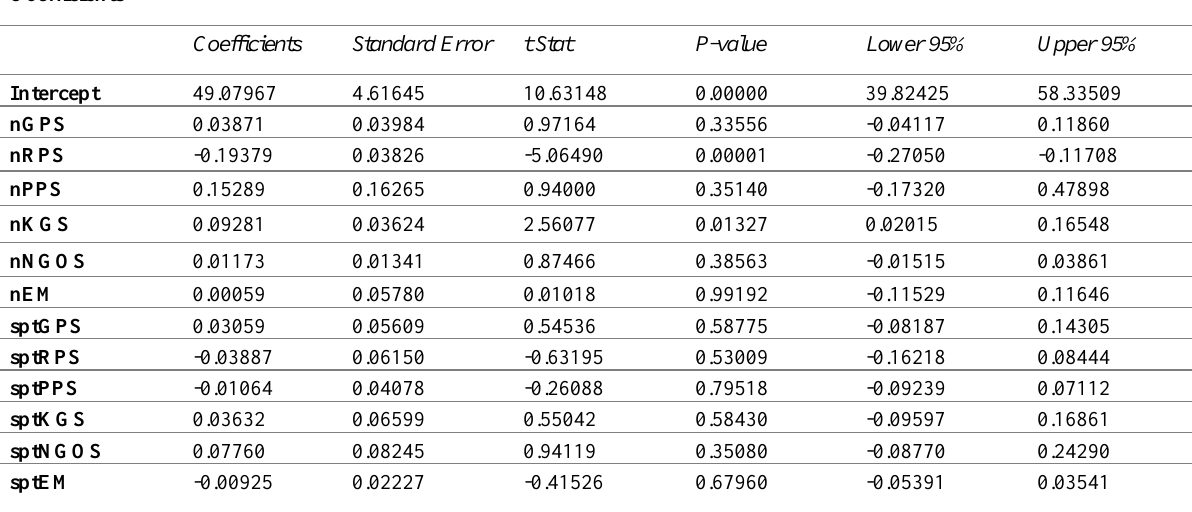
Table 21: Coefficients (Rajshahi